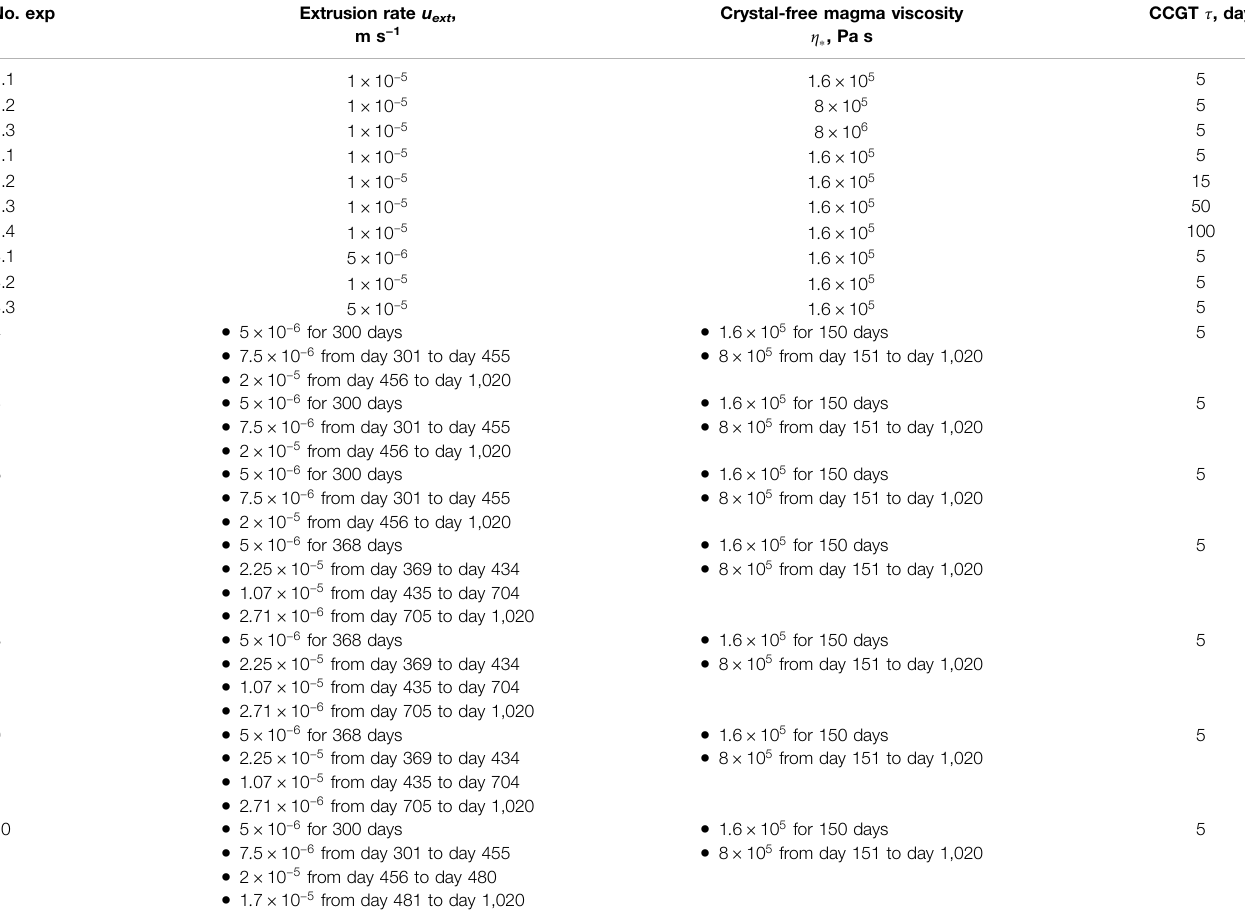
TABLE 1 | Numerical experiments and their model